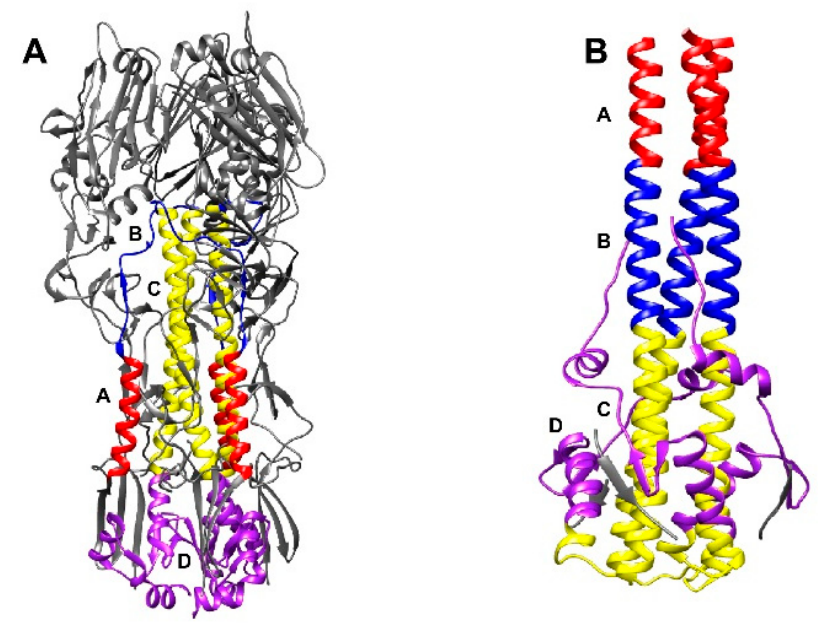
Figure 1. Hemagglutinin (HA) structures in the pre-fusion and post-fusion conformation. ( A ) Prefusion HA conformation with helices A (red), C (yellow), and D (purple) and B loop (blue) in each protomer colored distinctly (PDB code; 4FNK) [10]. ( B ) Post-fusion HA conformation colored as in (A) (PDB code; 1HTM) [11]. Note that in the post-fusion confirmation, the B loop folds into the helix B in the extended helix and most of HA1 is not present in this structure.